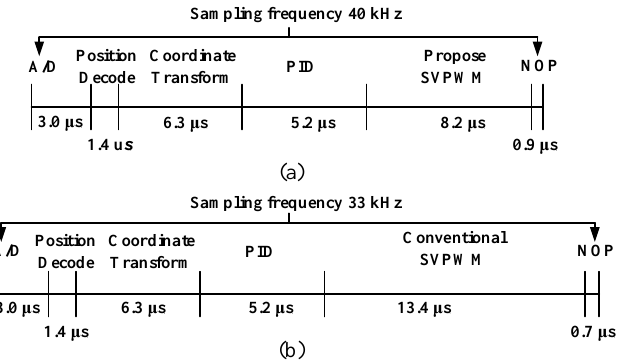
Figure 19. ( a ) Time consumption of the FOC with proposed SVPWM algorithm. ( b ) Time consumption of the FOC with conventional SVPWM algorithm.